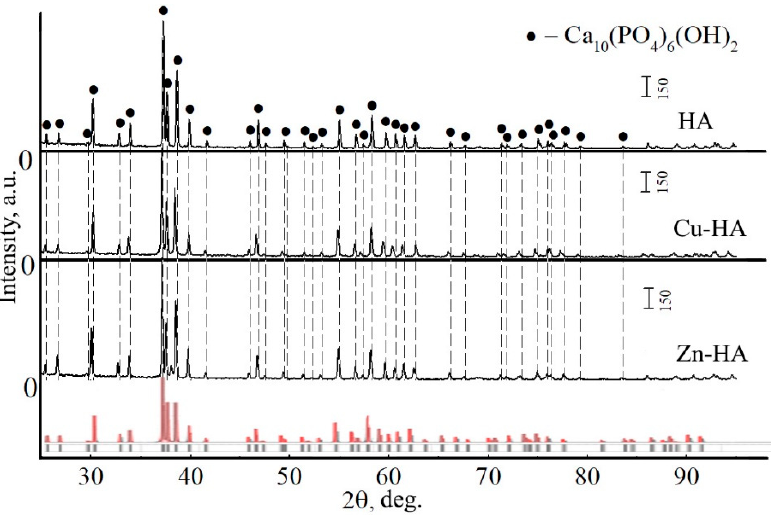
Figure 4. XRD patterns of HA, Cu-HA, and Zn-HA targets after sintering (red and gray lines repre-